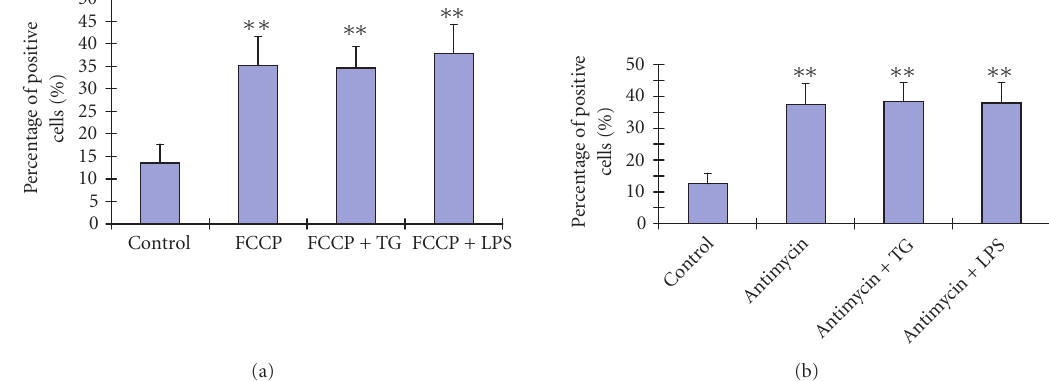
Figure 6: (a) E ff ect of mitochondrial uncoupler carbonyl cyanide p -trifluoromethoxy-phenylhydrazone (FCCP) on thapsigargin and LPS- evoked generation of ROS. When the FCCP (1mM) was added to the cells, a significant increase in ROS production was observed at 10 minutes. In the presence of FCCP, stimulation of cells with 2 μ M TG or 10 μ g/mL LPS failed to induce further increases in ROS level. (b) E ff ect of antimycin on thapsigargin and LPS-evoked generation of ROS. Treatment of cells with 5mM antimycin led to a significant increase in ROS generation at 10 minutes. In the presence of the antimycin, stimulation of cells with 10 μ g/mL LPS failed to evoke further increases in ROS production. A similar result was obtained when the cells were challenged with TG (2 μ M) in the presence of the antimycin. Three independent experiments have been performed. TG: thapsigargin. (cid:0)(cid:0) P < . 01 versus control